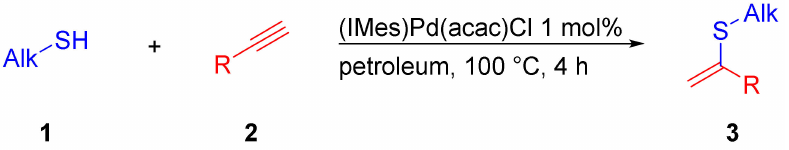
Figure 1. Model click reaction between aliphatic thiol ( 1 ) and alkyne ( 2 ) catalyzed by the Pd/NHC complex and resulting in the formation of vinyl sulfide ( 3